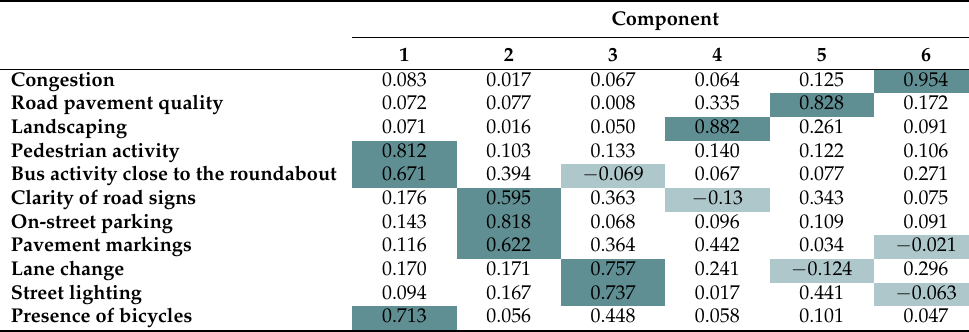
Extraction method: principal component analysis. Rotation method: Equamax with Kaiser nor- malization. a. Rotation converged in 18 iterations.